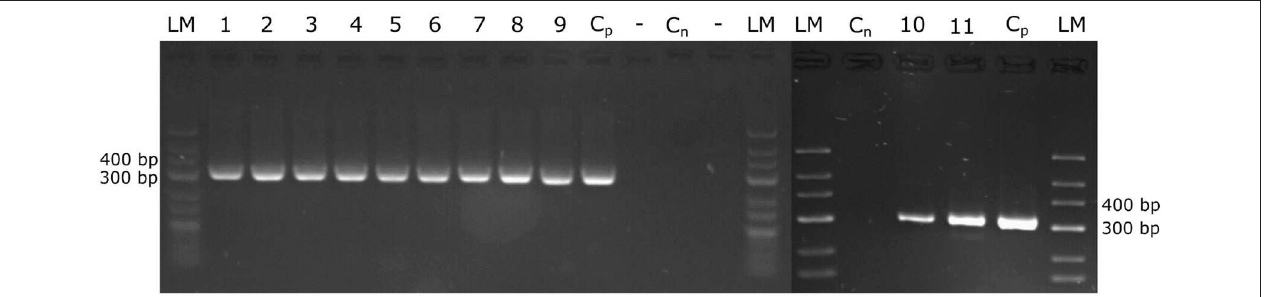
FIGURE 2 | Amplification of the P. viticola ITS region. DNA was extracted from petioles and from shoot tips that were evaluated from the natural infected field plants by microscopy. The extracted DNA served to amplify the ITS-region of P. viticola , expecting a specific fragment size of 314 bp. The amplified PCR fragments were separated on 3% agarose-gels. The size standard applied is “GeneRuler Low Range DNA Ladder” (Thermo Scientific TM ). Cp, positive control; Cn, negative control; 1, 2, 3, “Pinot noir”; 4, 5, 6, “Müller Thurgau”; 7, 8, 9, “Pinot blanc”; 10, 11,